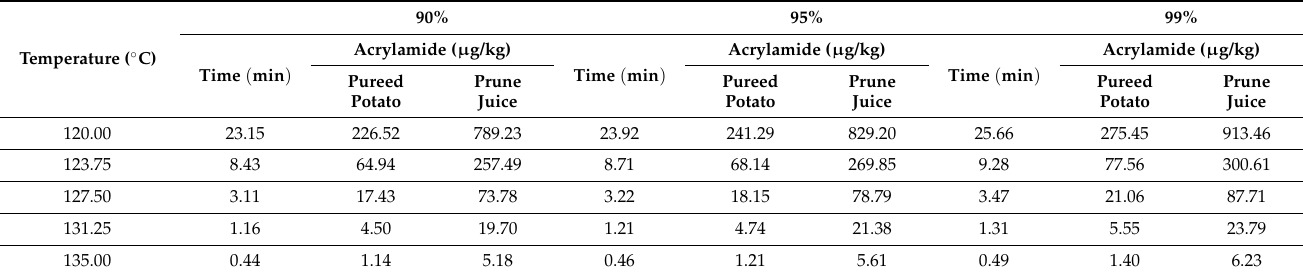
Table 2 quantifies the time and acrylamide formed for each temperature and three values of P ( log 10 S ≥ 6 ) . For a probability of inactivation of 95%, if the temperature is increased by 12.5% (from 120 to 135 ◦ C), the treatment time is reduced by 98% (from 23.92 to 0.46 min). Higher acrylamide amounts were observed for prune juice, as the amount of reducing sugars is higher than in pureed potato, although the qualitative appearance of the dynamics of the objectives is the same for both foods. The previously mentioned 12.5% increase in temperature (that would imply a 98% reduction in the treatment time) would result in a 99.5% and 99.3% reduction in acrylamide for pureed potato and prune juice, respectively. Therefore, as kinetics behave differently for temperature changes, an additional analysis to find the optimal trade-off between both objectives was performed, based on a multi-objective approach. Table 2. Acrylamide formed and duration for different heat treatments and inactivation